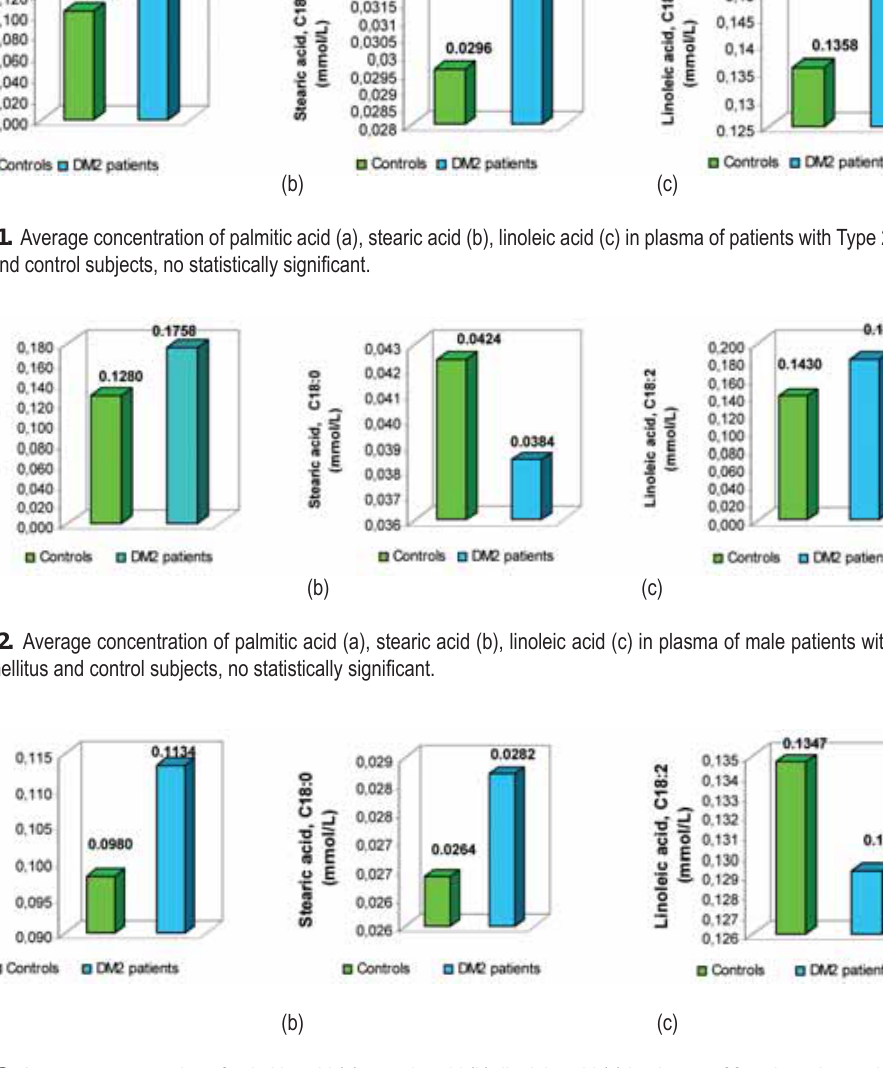
FIGURE 3. Average concentration of palmitic acid (a), stearic acid (b), linoleic acid (c) in plasma of female patients with Type 2 dibetes mellitus and control subjects, no statistically signi fi